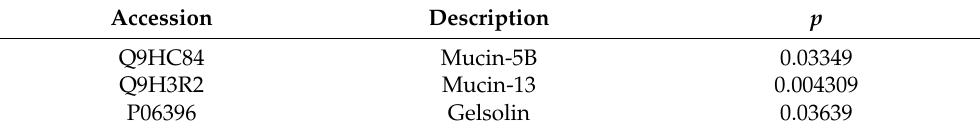
Table 2. List of genes downregulated in active UC compared with those in remission